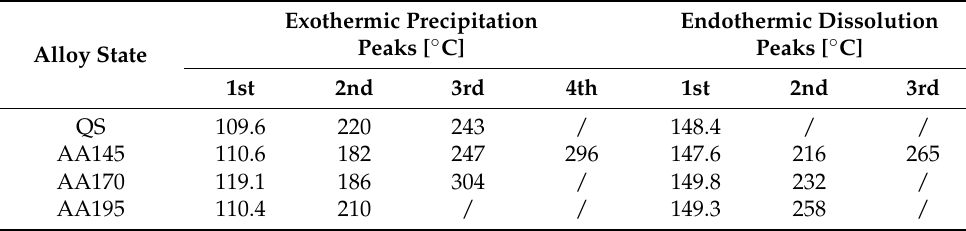
Table 3. Reference temperatures of the onset of decomposition of the age-hardened